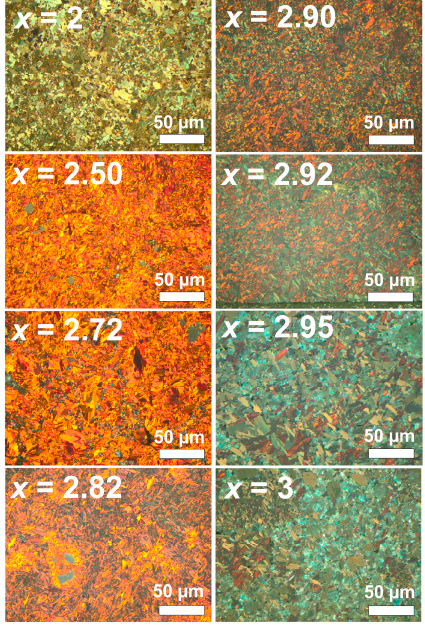
Figure 7. Polarized light microscopy (PLM) of WO x materials. A yellowish-to-red-to-bluish color variation with increasing O/W-ratio x is observed due to the different optical reflectivity of the occurring phases. occurring